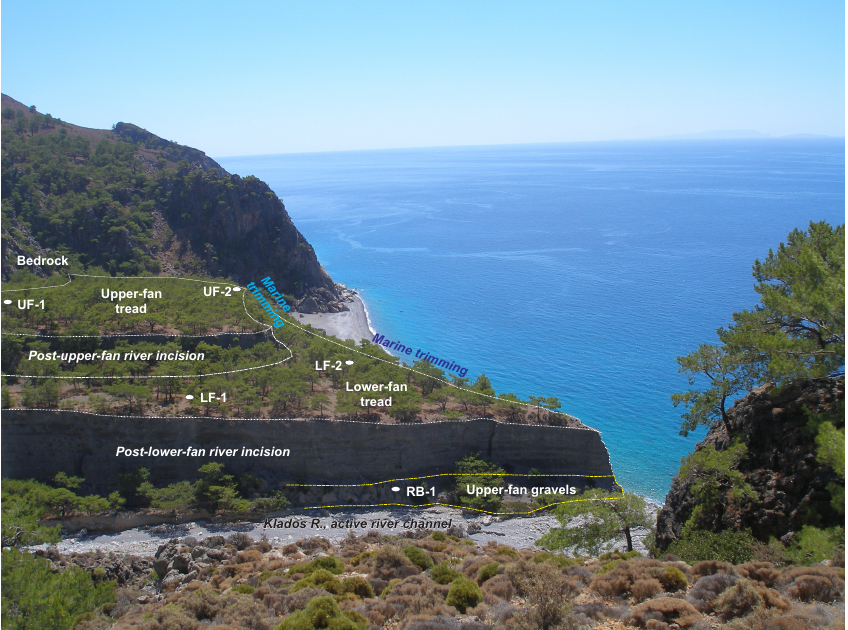
Figure 3. The fan sequence at Domata looking obliquely towards the southeast. The two fan surfaces and their respective stream-incised cliffs are illustrated. The yellow dashed line in the present stream cliff indicates the benched upper-fan erosional surface, which is overlain by the deposits of the lower fan. This important marker was used to calculate a long-term (39kyr) uplift rate at Domata (see text for details). White spots mark the location of IRSL